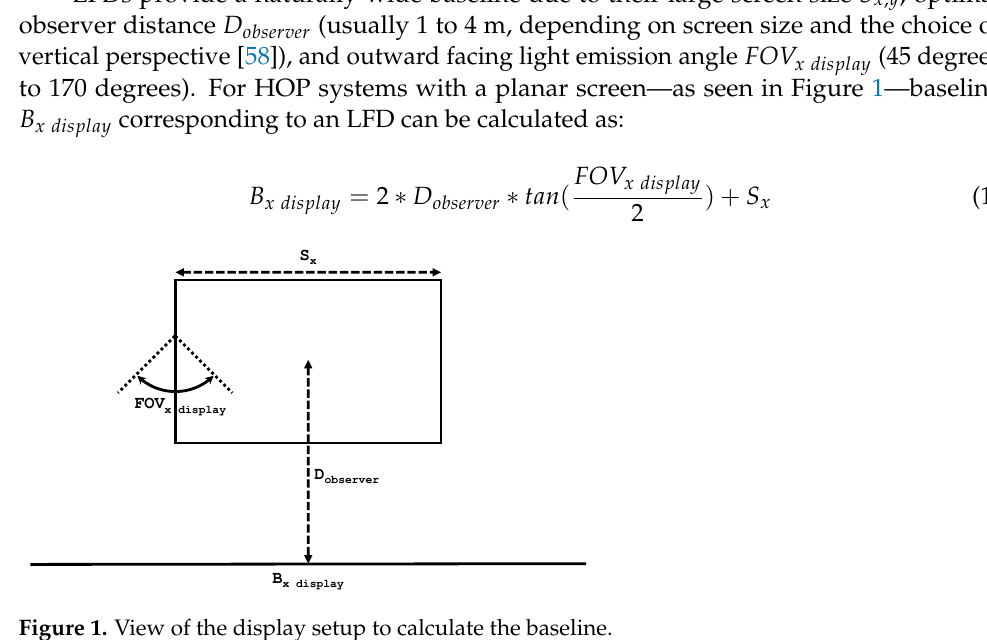
Figure 1. View of the display setup to calculate the